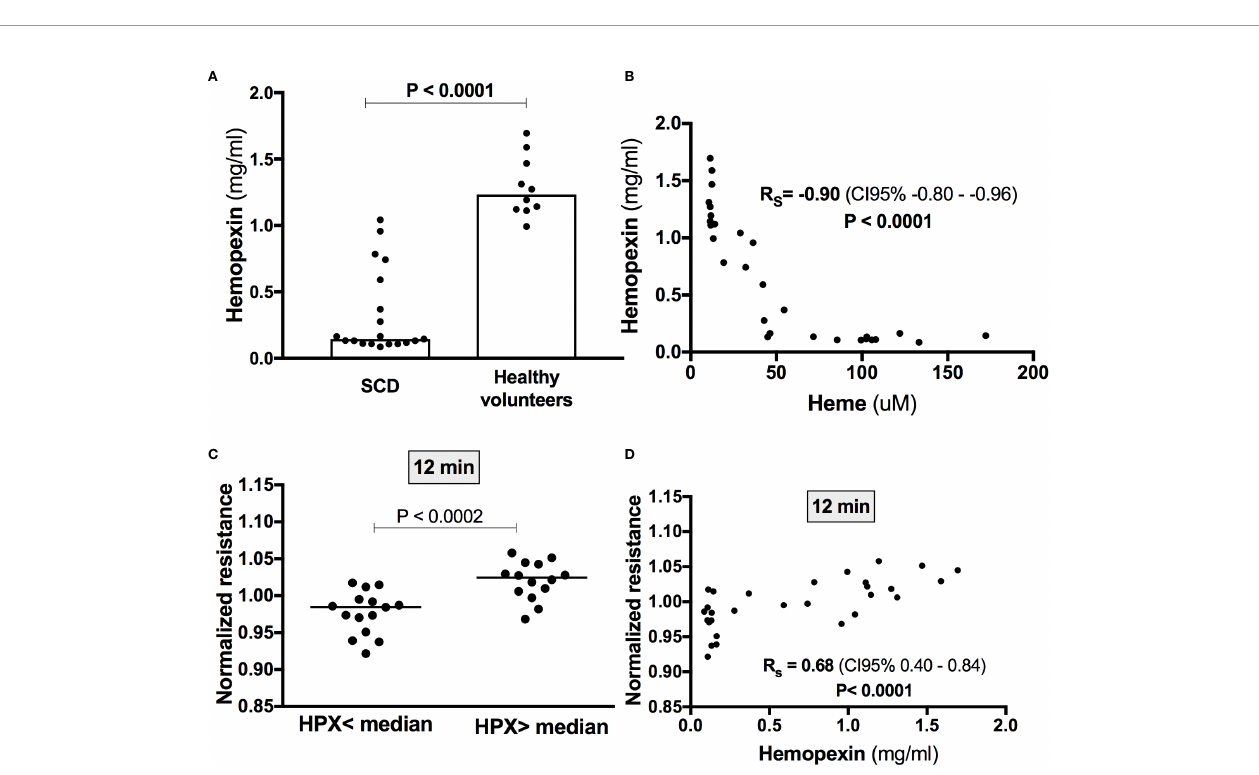
FIGURE 4 | Heme-induced EB disruption in the presence of serum is associated with hemopexin levels. (A) Hemopexin levels were measured by Elisa and were lower in SCD patients (n=19) compared to healthy volunteers (n=10) (Mann-Whitney test). (B) A strong negative correlation was observed between hemopexin and heme levels (Spearman correlation coef fi cient). (C) Lower values of normalized resistance at the timepoint of peak heme-induced EB disruption were observed in individuals with lower hemopexin levels (t test). Accordingly, peak heme-induced EB disruption (i.e., after 12 min) was statistically correlated with hemopexin levels (Spearman correlation coef fi cient) (D)